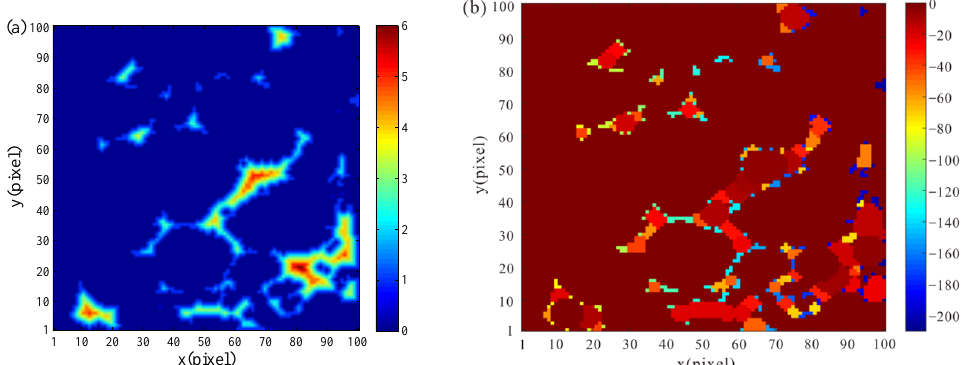
Figure 5. ( a ) The distribution of d for one layer of digital rock. The value of the color bar represents the number of pixels. ( b ) The distribution of S for one layer of digital rock. The value in the color bar represents the number of S .